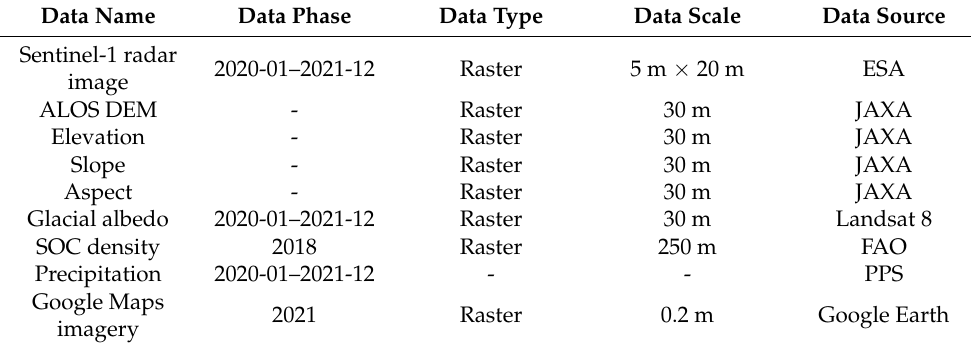
Table 1. Data sources and